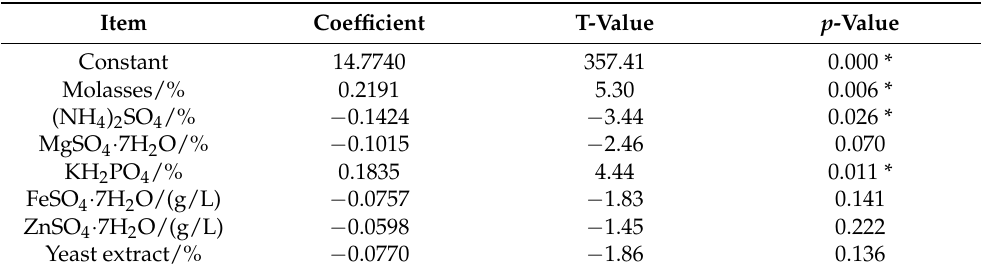
Figure 4. RNA content and growth in different culture temperature ( a ) and pH ( b ) before sterilization of G03H8. Data are the average of three independent experiments. Error bars represent ± SD. Table 4. Regression results of the PB